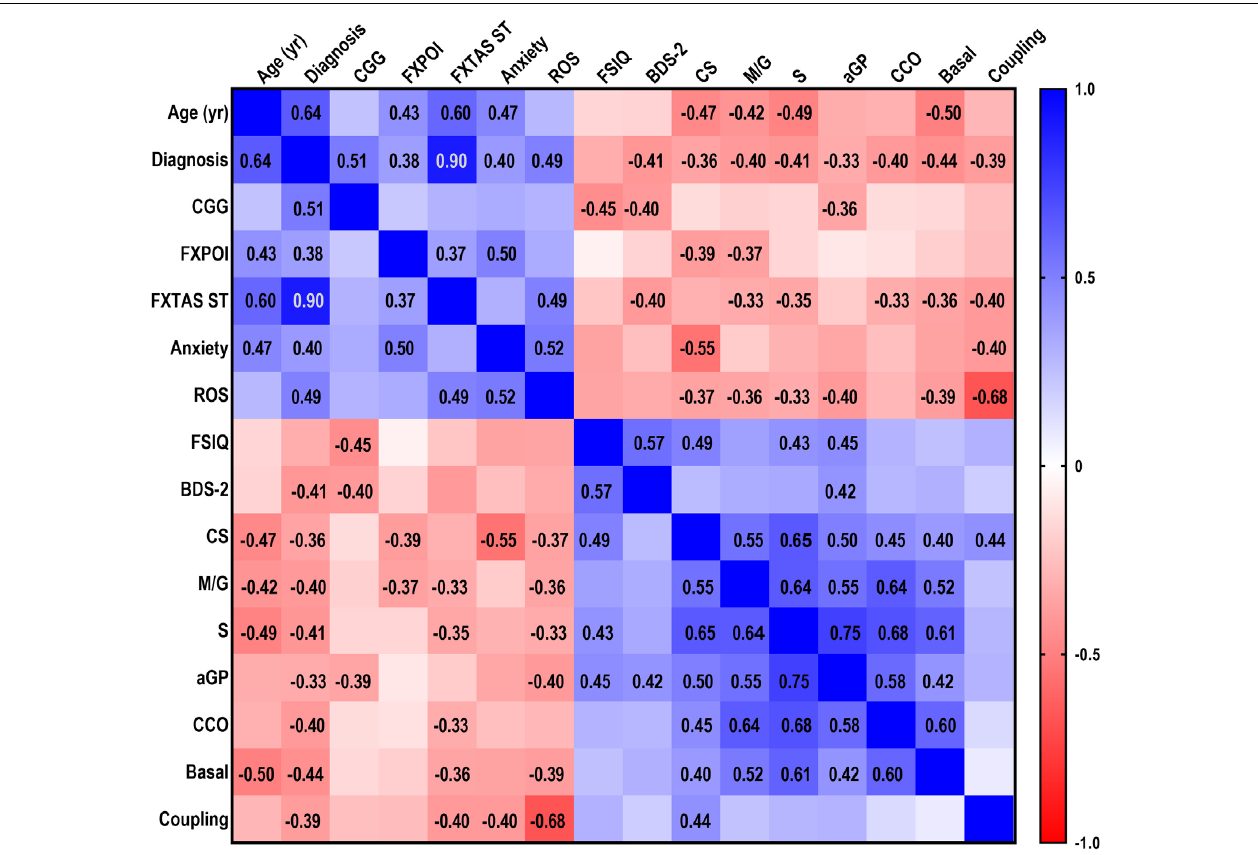
FIGURE 1 | Correlations between demographic, clinical and mitochondrial outcomes. A multivariable correlation matrix was built with demographic, clinical and functional data relative to PM without ( n = 22) and with ( n = 20) FXTAS symptoms and control ( n = 10) women age 24–70 year, along with biochemical mitochondrial outcomes measured in lymphocytes obtained from the same individuals. Outcomes analyzed were: age, diagnosis, CGG (all with n = 52), FXPOI ( n = 47), FXTAS stage ( n = 51), anxiety ( n = 36), Full Scale IQ (FSIQ; n = 31), Behavioral Dyscontrol Scale-2 (BDS-2; n = 32), ROS ( n = 46), citrate synthase activity (CS; n = 52), NADH-fueled ATP-linked O 2 consumption (M/G; n = 52), succinate (S)-sustained FADH 2 -fueled ATP-linked linked O 2 consumption ( n = 52), α -glycerophosphate ( α GP)-dependent ATP-linked O 2 consumption ( n = 50), cytochrome c oxidase activity (CCO; 51), basal respiration ( n = 51), coupling ( n = 50). Categorical variables (i.e., diagnosis, FXPOI, anxiety) were assigned a numerical value. Diagnosis: control = 0, PM without FXTAS = 1, PM with FXTAS = 2; FXPOI and anxiety: absence = 0, presence = 1. Due to the non-Gaussian distribution of the data, the non-parametric Spearman test was run. R values are shown for those correlations which were statistically significant at p ≤ 0.01. A scale showing the range of r values (from –1.0 for inversely correlated outcomes to 1.0 for positively correlated ones) is also